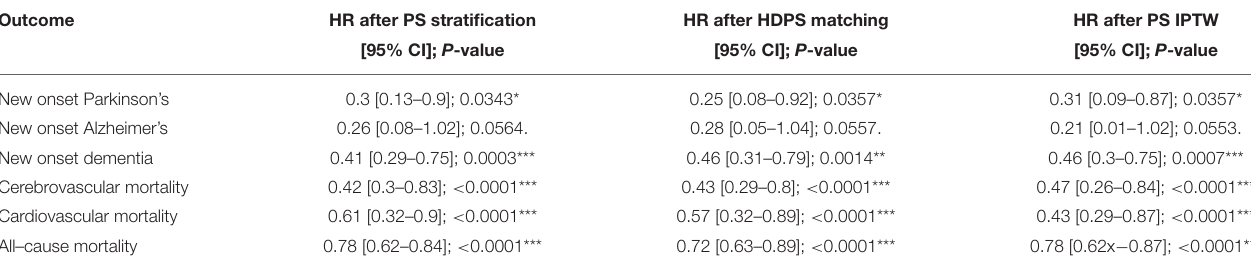
TABLE 4 | Risk of incident adverse cognitive dysfunction events, and mortality outcomes in matched cohorts associated with the treatment of SGLT2I vs. DPP4I using different matching approaches.